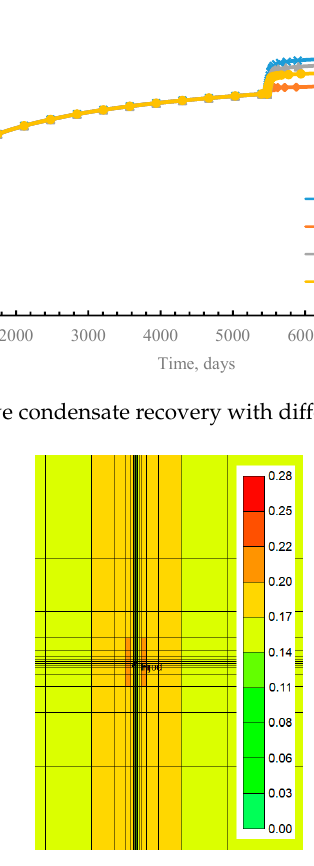
Figure 13. Main condensate region after primary depletion.